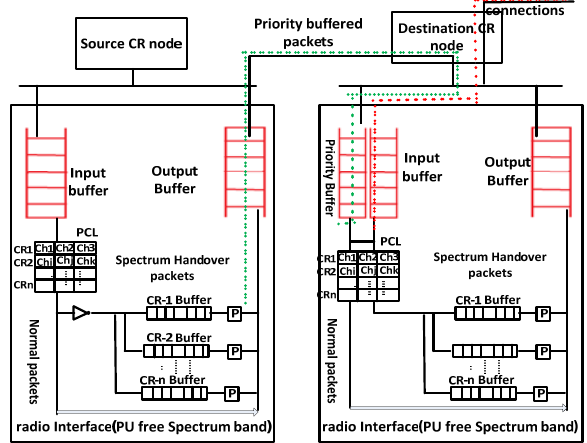
Figure 7. Overview of spectrum handover packet buffering.